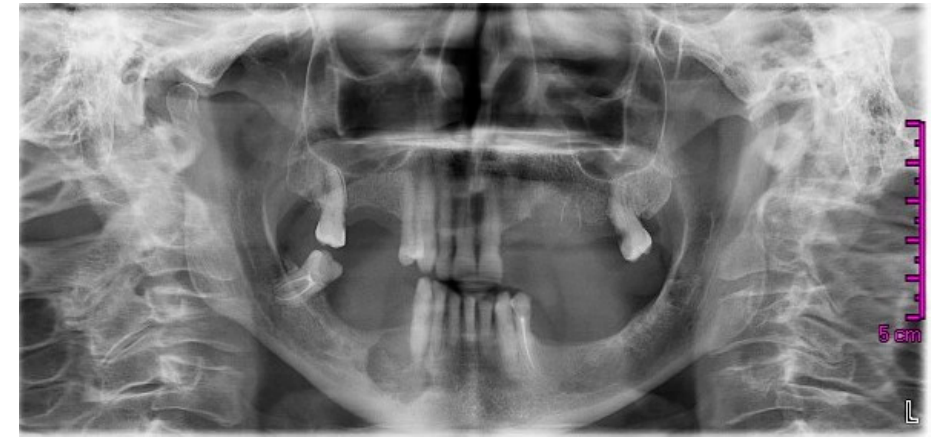
Figure 3. Orthopantomography dated October 2014, after extractions of teeth 24, 25, and 44. A wide radiolucent area involving the bone distal to 43 was present together with less-defined alterations in the upper left quadrant.